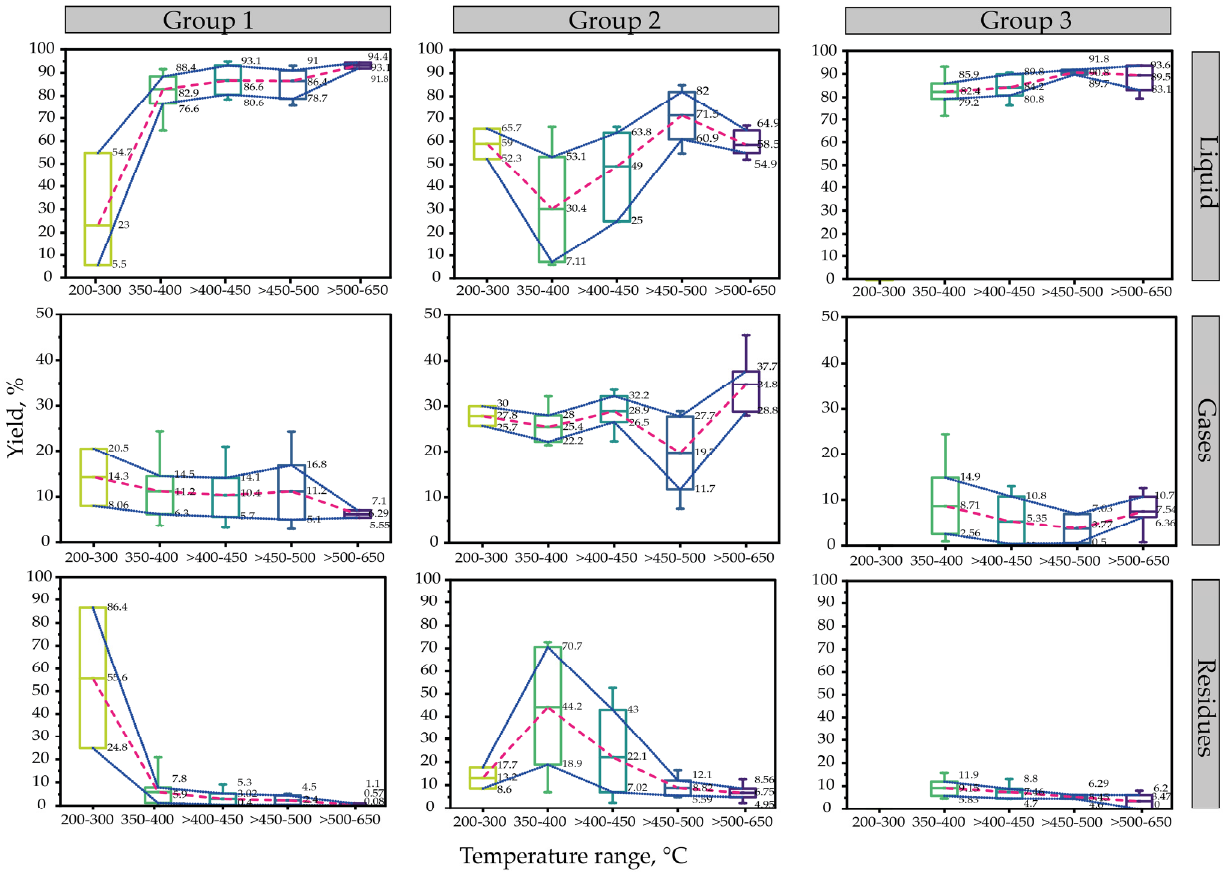
Figure 6. Influence of temperature on products yields in PS thermal pyrolysis.